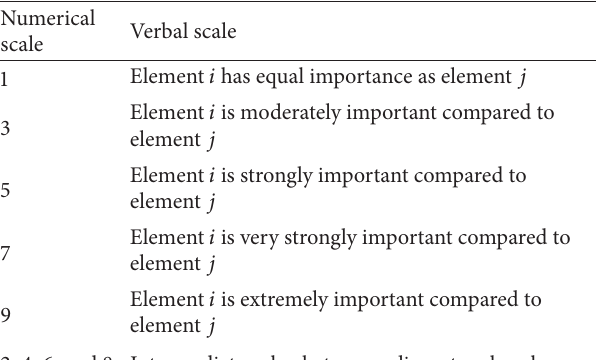
Table 1: Comparison